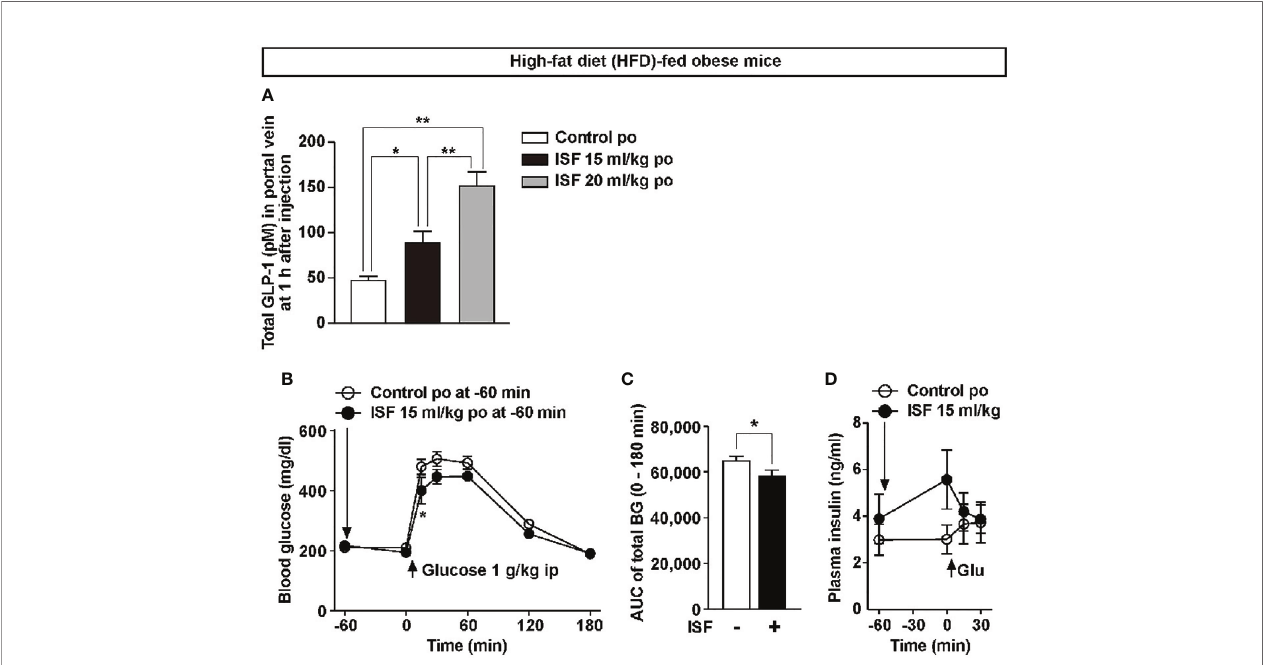
FIGURE 5 | ISF promotes GLP-1 secretion in a dose-dependent manner and improves glucose tolerance in high-fat diet (HFD)-fed obese mice. (A) Total GLP-1 concentrations in portal vein plasma at 1 h after po ISF (15 or 20 ml/kg) in HFD-fed obese mice fasted overnight (A) , which exhibited obesity. n = 6. ** p < 0.01, * p < 0.05 by one-way ANOVA followed by Tukey ’ s test (A) . (B – D) ISF (15 ml/kg) or control solution was po administered at 60 min prior to ipGTT (1 g/kg) in HFD- fed obese mice fasted for 4 h. Blood glucose (B) , its AUC (C) and plasma insulin (D) . n = 5 – 6. * p < 0.05 by two-way ANOVA followed by Bonferroni ’ s test vs . control (B) , and * p < 0.05 by unpaired t -test (C)